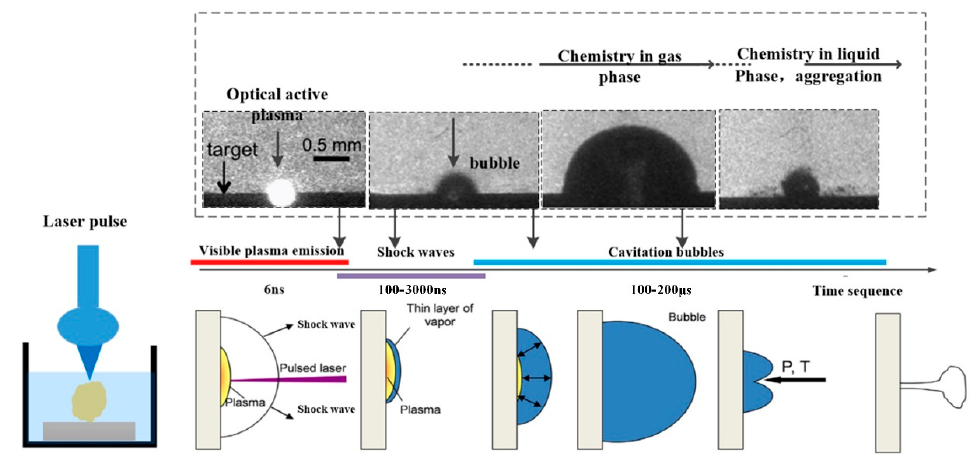
Figure 5. Time duration of plasma emission, shock wave formation, and bubble collapse during the LAL process. Reprinted/adapted with permission from Ref. [36]. Copyright 2015, Elsevier.